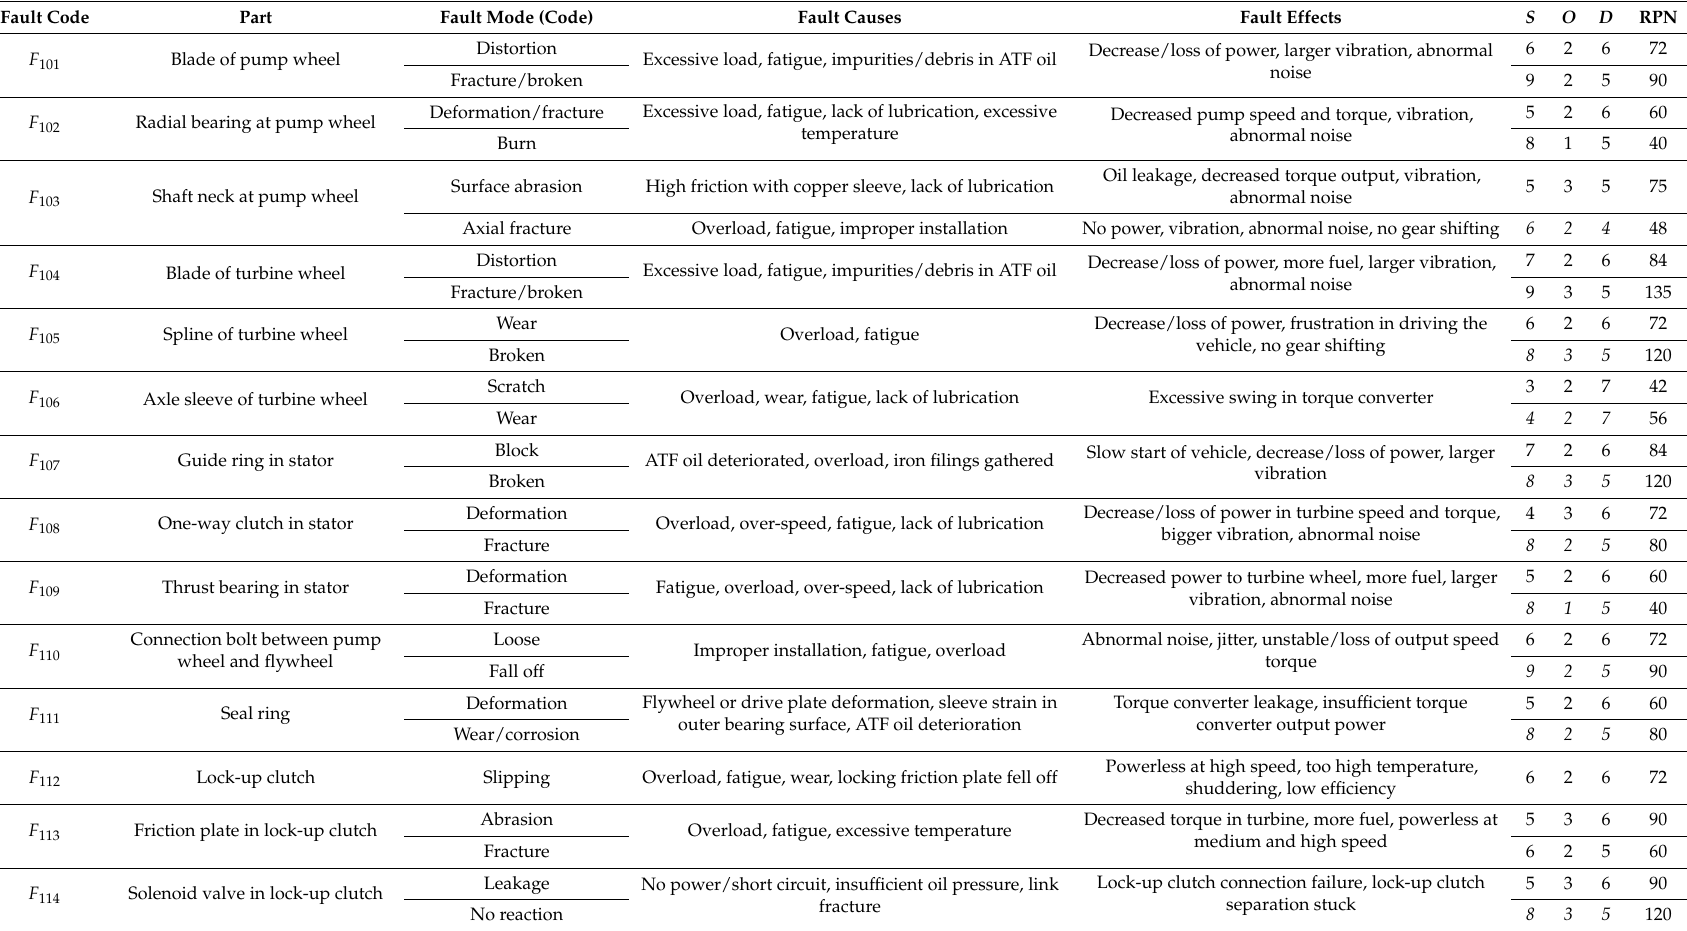
Table 1. Fault mode and effect analysis (FMEA) results of hydraulic torque converter. S, severity; O, occurrence; D, detection; RPN, risk priority number; ATF, automatic transmission